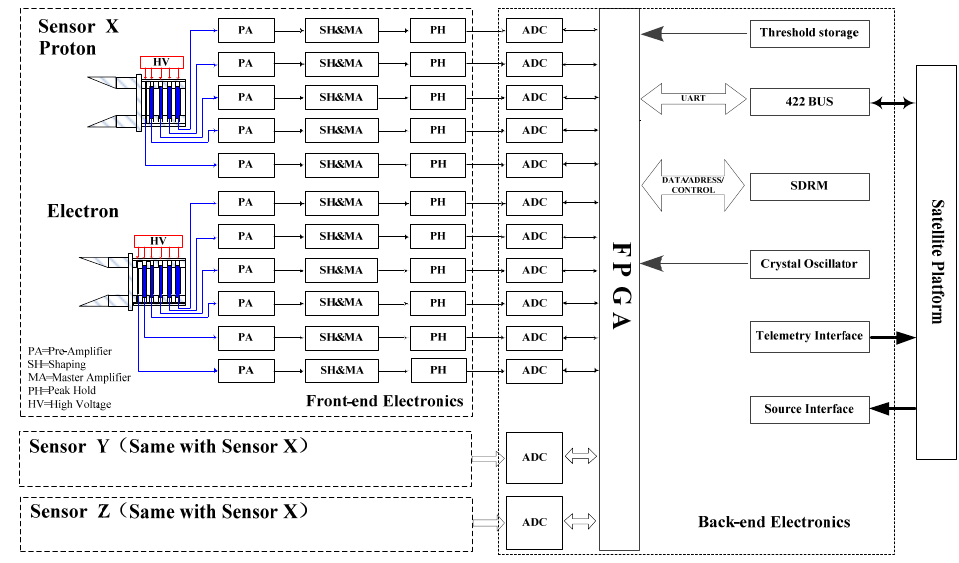
Figure 12. Schematic diagram of the HEPD’s electronics principle.